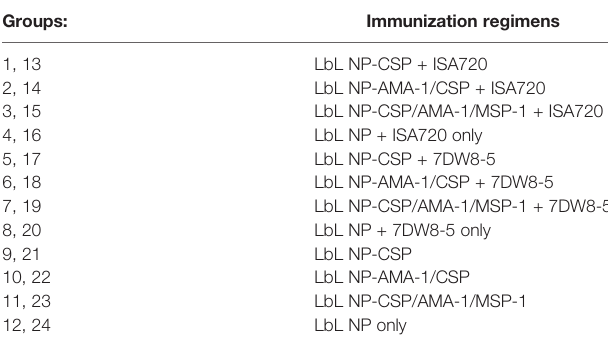
TABLE 1 | Vaccine candidate formulation compositions in Immunogenicity Study. 1-12 group animals were injected by two doses of vaccine candidates, but 13-24 group animals were injected by three